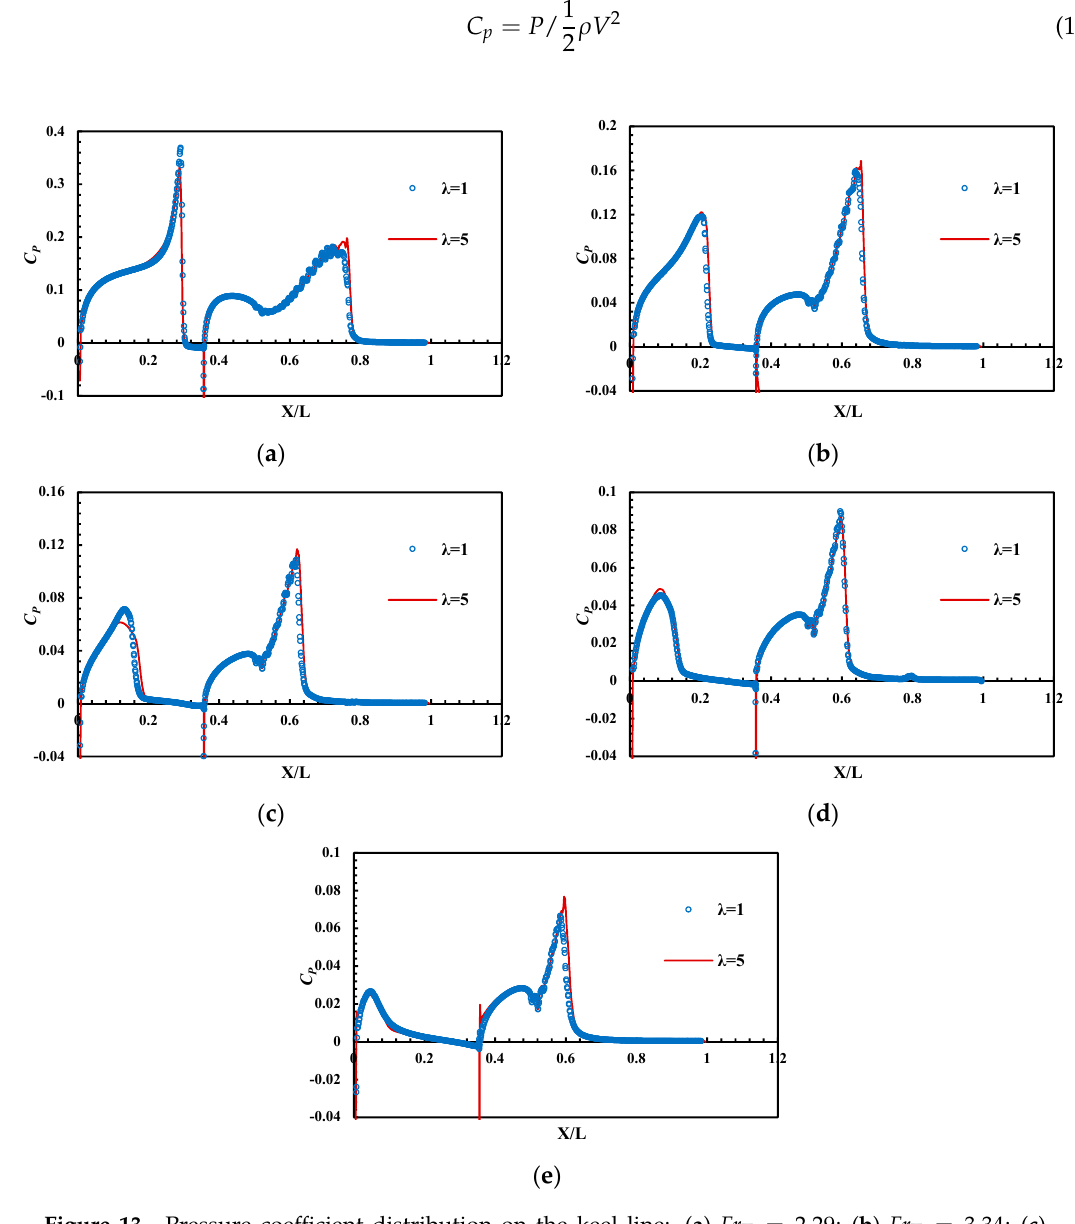
Figure 13. Pressure coefficient distribution on the keel line: ( a ) 𝐹𝑟 ∇ = 2.29 ; ( b ) 𝐹𝑟 ∇ = 3.34 ; ( c ) 𝐹𝑟 ∇ = 4. .58 ; ( d ) 𝐹𝑟 ∇ = 5.73 ; ( e ) 𝐹𝑟 ∇ = 6.87.